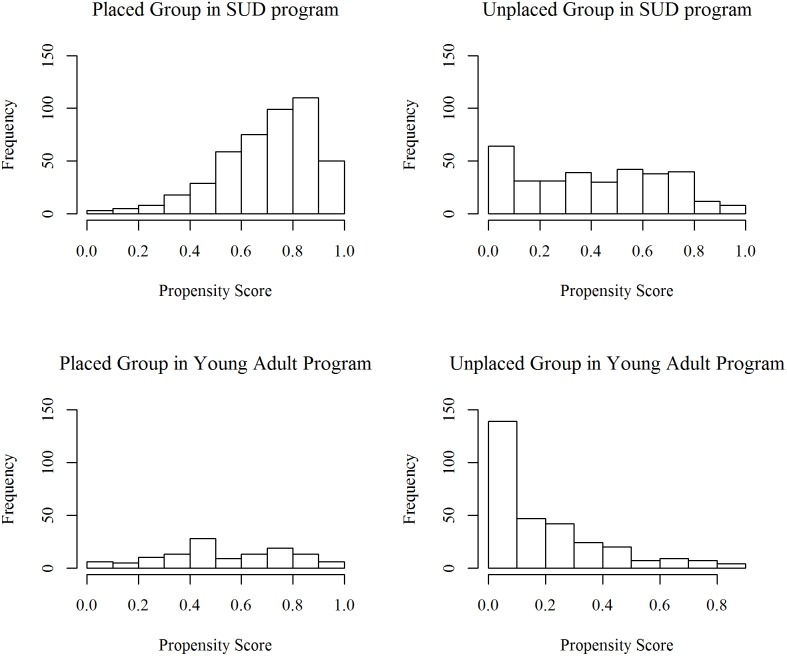
Distribution of Propensity Scores for Supportive Housing Tenants and Unplaced Applicants in Programs.This figure describes the distribution of propensity scores for placed and unplaced subjects in SUD and young adult populations. In each population, there was substantial overlap in the distributions between placed and unplaced subjects, meeting an important prerequisite for propensity score matching. Abbreviations: SUD, substance use disorder. Data sources: NYC Department of Homeless Services, NYC Department of Correction, NYC Department of Health and Mental Hygiene, NYC Human Resources Administration and within it Customized Assistance Services and the NYC HIV/AIDS Services Administration, and New York State Office of Mental Health.